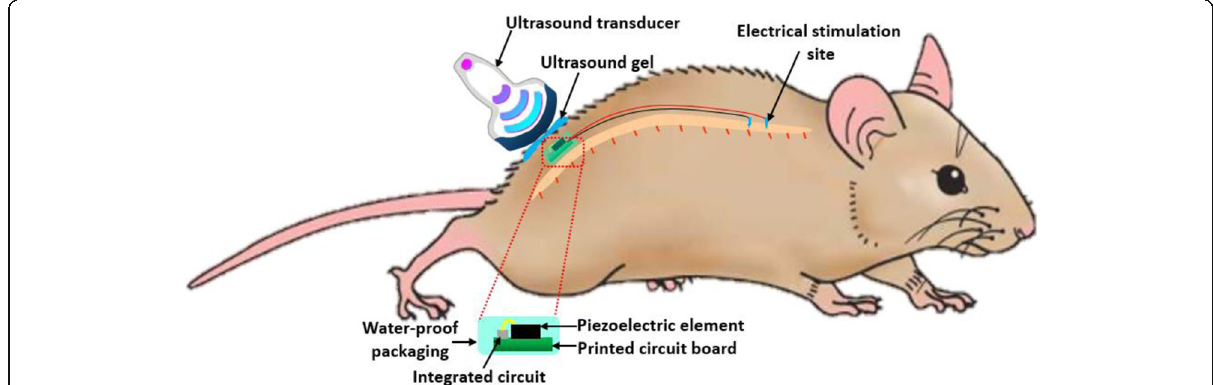
Fig. 1 Working principle of the ultrasound-driven piezoelectric stimulator interfacing the spinal cord for the restoration of involuntary locomotion. The ultrasound energy provided by the probe is converted to electrical energy for neural stimulation by the implanted